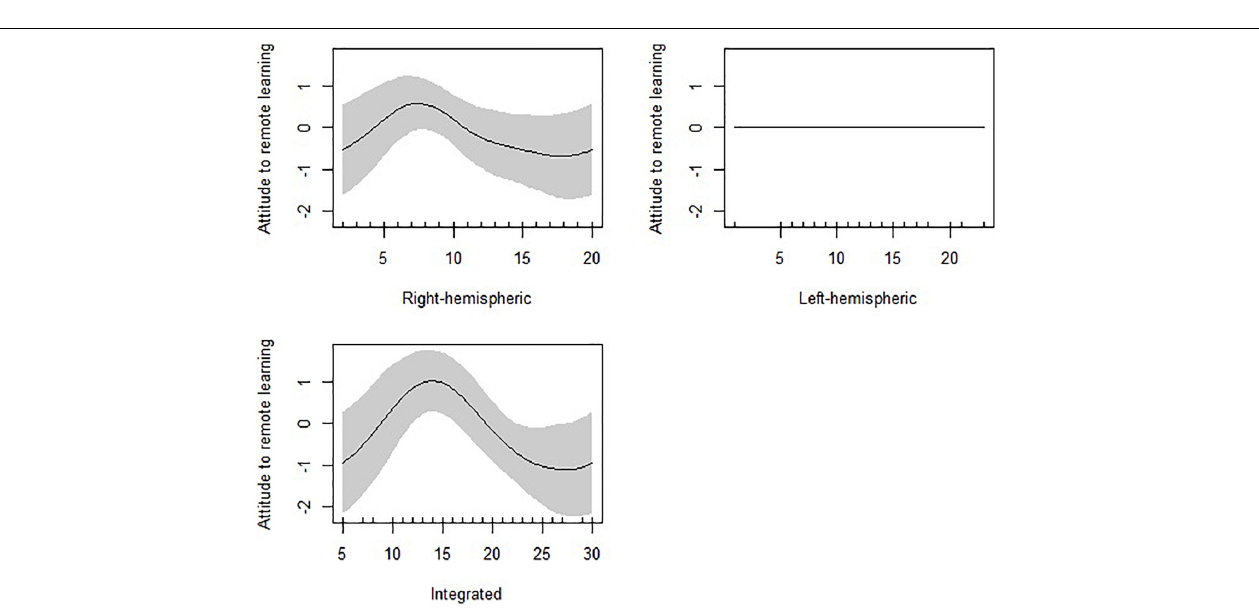
FIGURE 2 | GAM components (partial prediction), plots with 95% confidence intervals. Interpersonal communicative skills model.